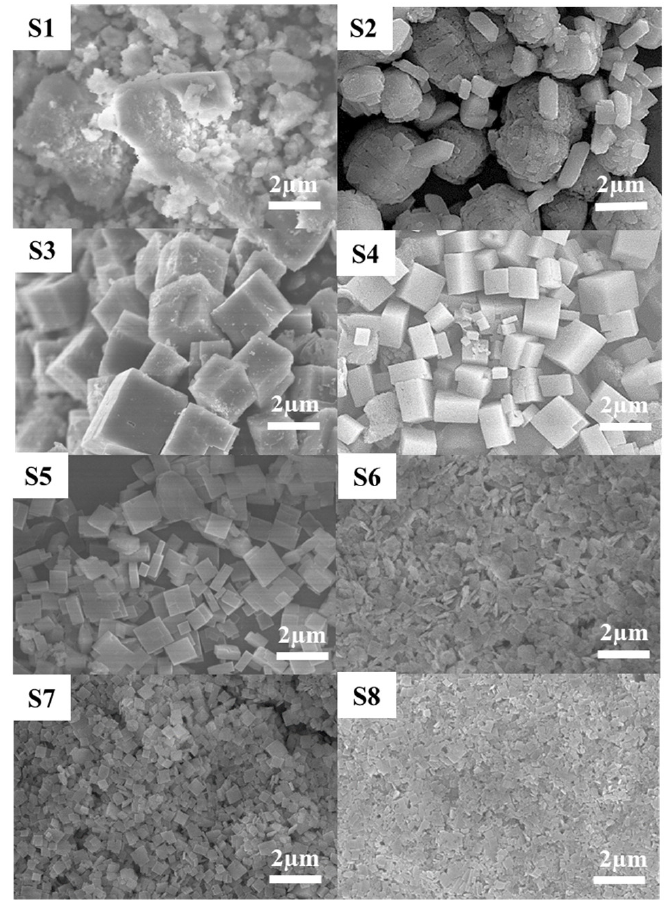
Figure 2. SEM images of the as-synthesized SAPO-34 particles with the variation of template con- centration ( S1 – S8 ).